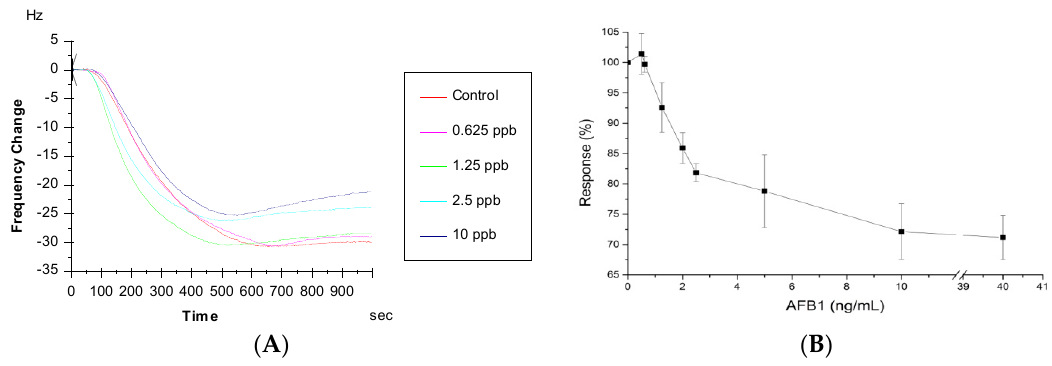
Figure 6. AFB1 sensor response with IgA antibody ( A ) Sensograms showing the sensor response at different concentrations of AFB1; ( B ) Sensor response curve for AFB1 detection. Error bars represent standard errors.